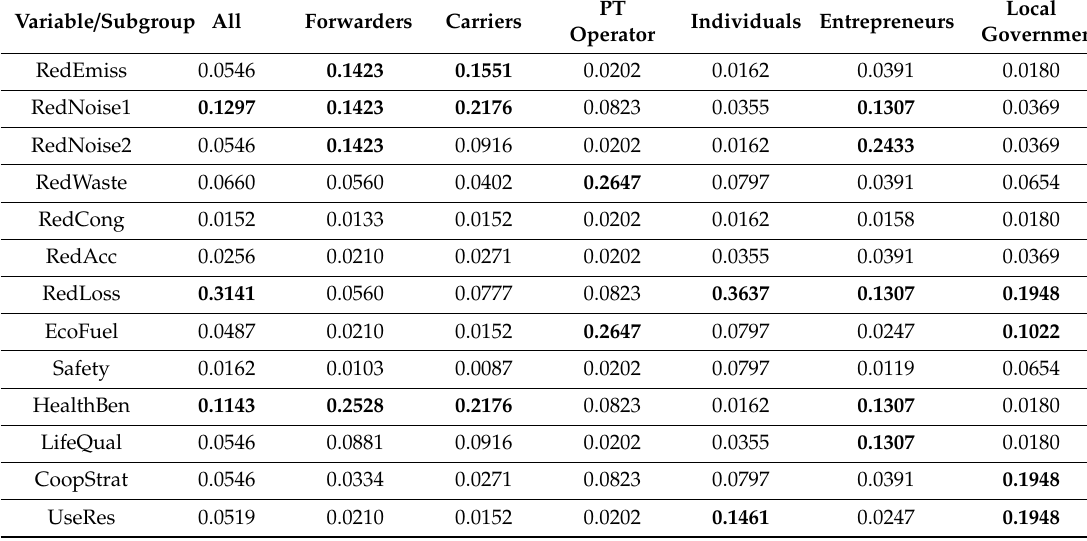
Table 5. Results of the AHP calculations (matrix of priorities)